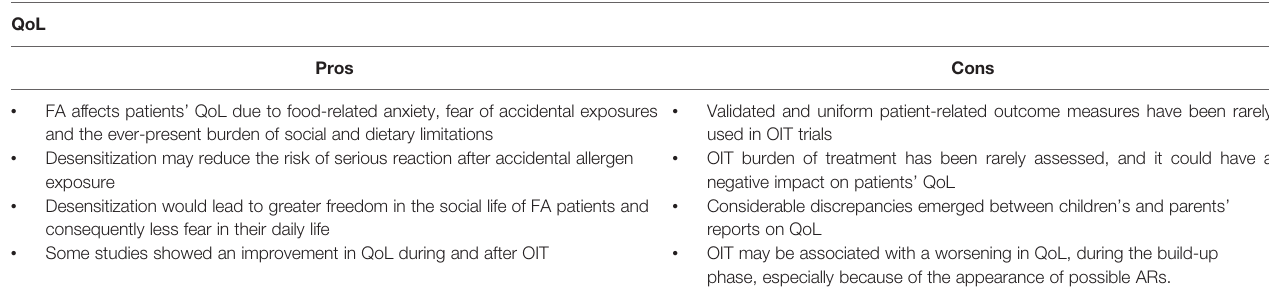
TABLE 3 | Impact of food OIT in children ’ s QoL – pros and